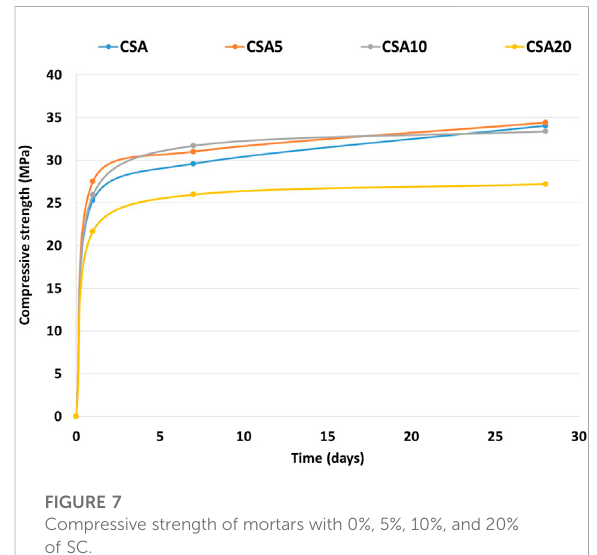
FIGURE 7 Compressive strength of mortars with 0%, 5%, 10%, and 20% of